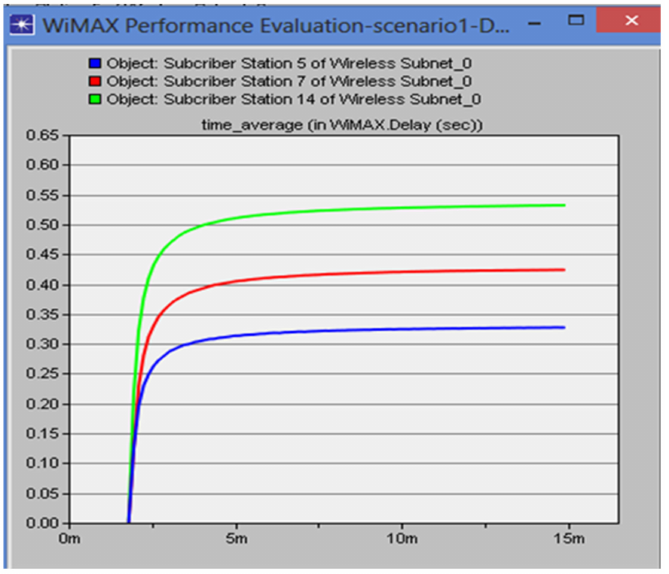
Figure 5. Traffic Delay.